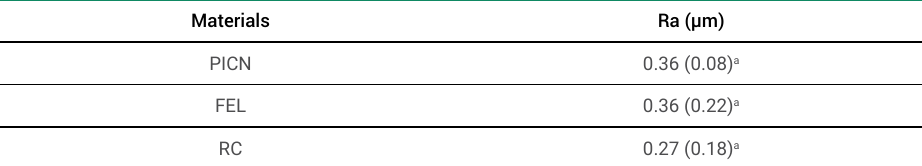
Table 2. Means (standard deviations) of average roughness (Ra) of each experimental group after polishing procedures.